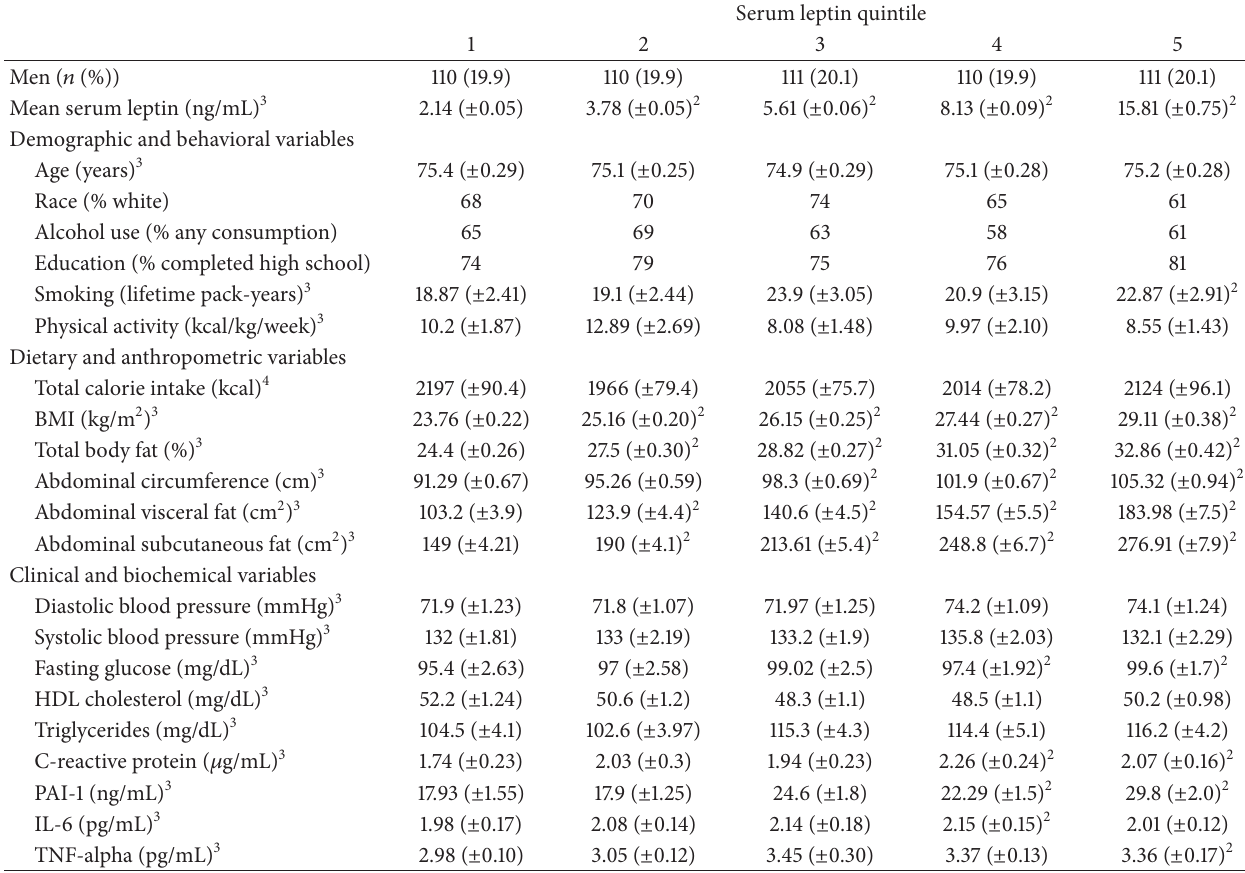
Table 1: Baseline characteristics of men by serum leptin quintile 1